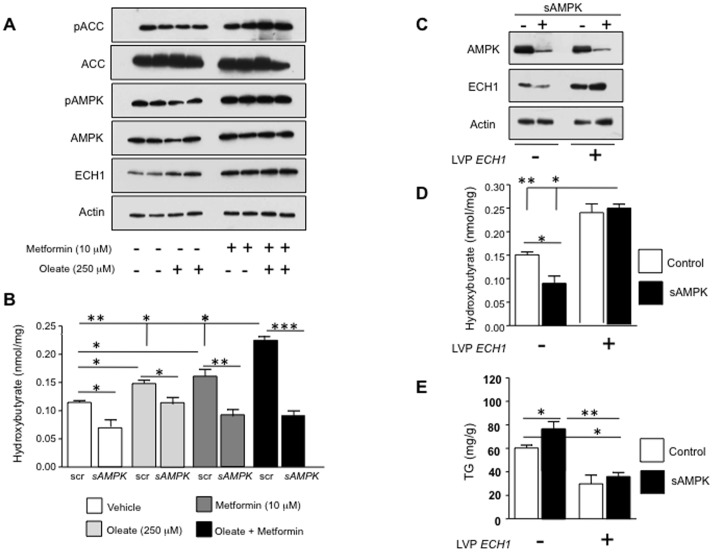
Activation of AMPK stimulates fat oxidation in HepG2 cells.A) Stimulation of AMPK activity by metformin (10 µM) significantly increases the phosphorylation of AMPK at Thr172, the phosphorylation of ACC at ser79 as well as the expression of the fat oxidation-related protein ECH1 (Enoyl CoA-hydratase) B) Metformin up-regulates the accumulation of β-hydroxybutyrate -a marker of fat oxidation activity- in cells exposed to oleic acid (250 µM, 72 hour). Hydroxybutyrate accumulation, ACC phosphorylation and ECH1 up-regulation by metformin does not occur in AMPK-deficient cells. *p<0.05, **p<0.01, ***p<0.001 C) Representative western blot showing over-expression of ECH1 in HepG2 cells (lanes 3 and 4) in control cells (lanes 1 and 3) and AMPK deficient cells (lanes 2 and 4). ECH1 overexpression restores the loss of fat oxidation observed in AMPK deficient cells and reduces fat accumulation as determined by a significant up-regulation of β-hydroxybuyrate levels (D) with paralleled decrease in intracellular triglyceride levels (E) *p<0.05, **p<0.01.